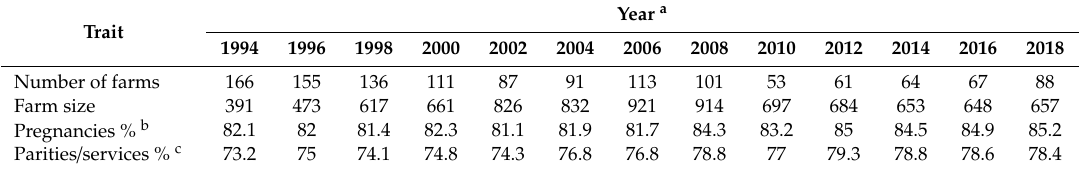
Table 2. Description of pregnancy and kindling rates on farms in Spain from 1994 to